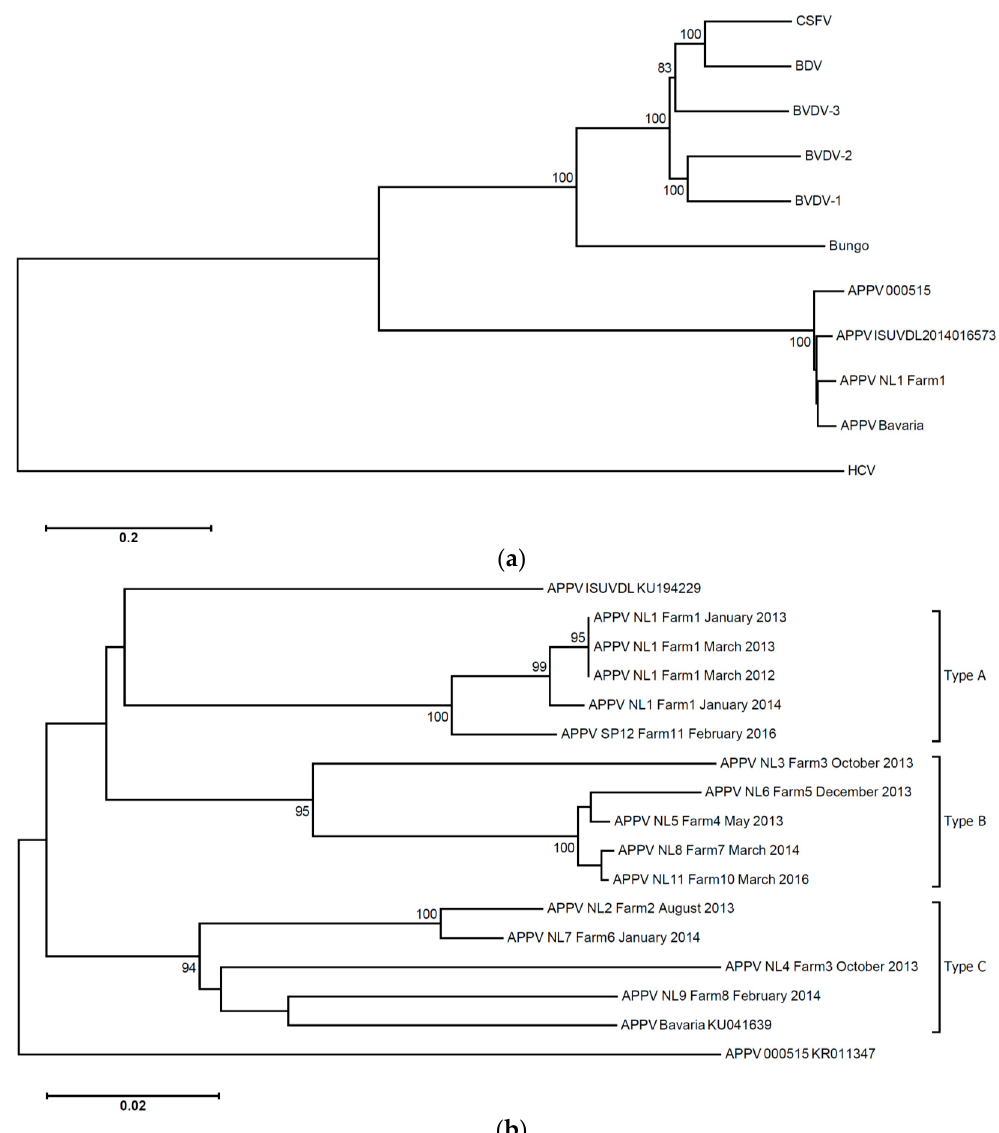
Figure 1. Phylogenetic analysis of the entire coding region (amino acid alignment) of atypical porcine pestivirus (APPV) NL1 Farm1, March 2012, among the known pestiviruses ( a ) and phylogenetic clustering (nucleotide alignment) into various APPV types ( b ). The neighbor ‐ joining method with complete deletion within the MEGA ‐ 6.06 package was used; bootstrap values above 80 (for 500 replications) are provided at the root of the clusters. The scale bar is a measure of the proportion of divergence. Hepatitis C virus (NC004102.1) is used as the outgroup in (a). BVDV ‐ 3: bovine viral diarrhea virus 3 (NC_012812.1); BDV: border disease virus (NC_003679.1); CSFV: classical